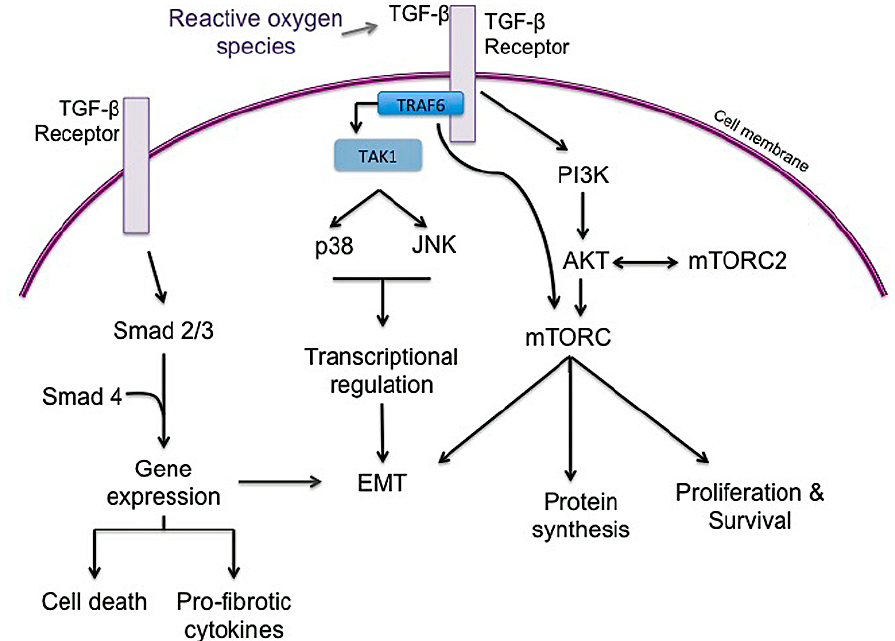
Figure 6. Schematic describing potential interactions of mTOR and TGF- β , a major driver of lung fibrosis. Both mTORC1 and mTORC2 likely plays a role in pulmonary fibrosis although the exact contribution from each complex is not clear. Both the canonical (Smad) and non-canonical (non-Smad) pathways may drive ongoing lung fibrosis, including altering metabolism, epithelial to mesenchymal transition (EMT), inflammation, and proliferation. It is possible that different mechanisms are predominate within different cell types to promote fibrosis; for example, Smad-dependent TGF- β signaling may trigger apoptosis in lung epithelial cells yet pro-fibrotic signals predominate in fibroblasts.